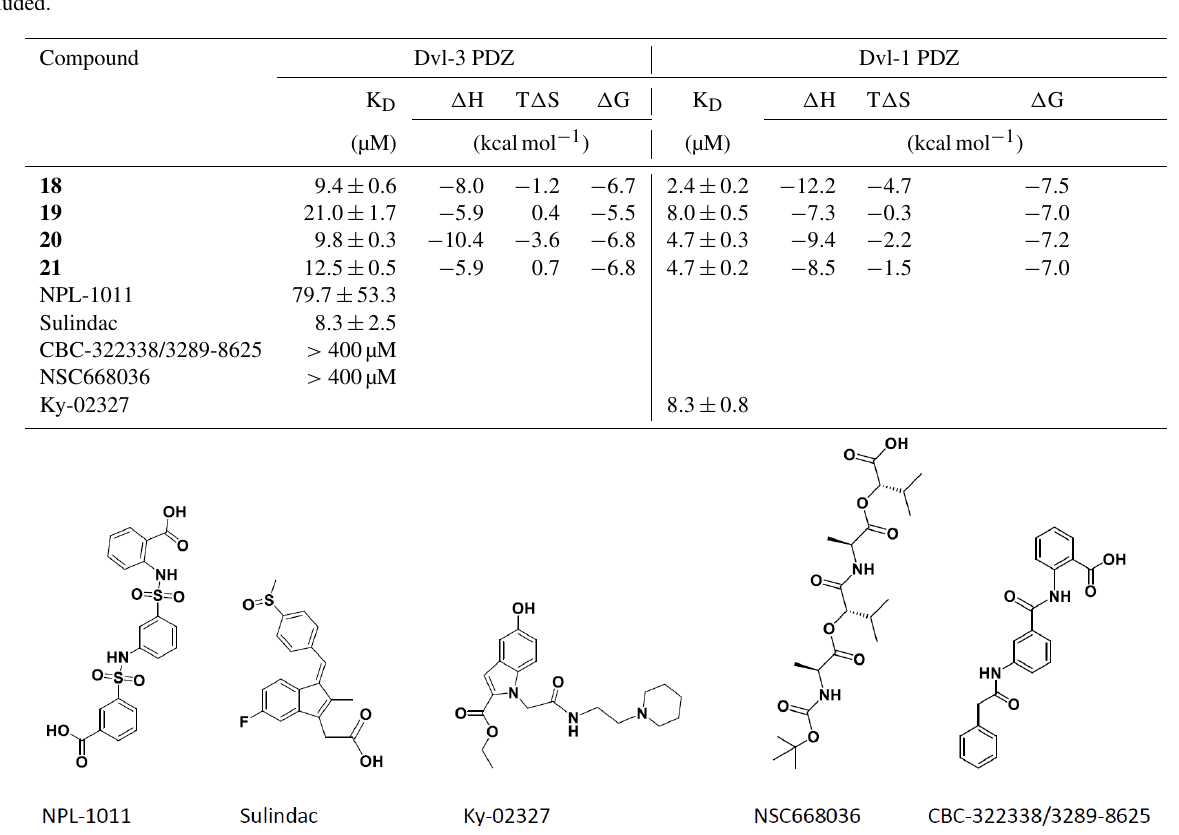
Table 2. Isothermal titration calorimetric data for the reaction between Dvl-3 PDZ; Dvl-1 PDZ; and our compounds 18 , 19 , 20 , and 21 . Compounds NPL-1011 (Hori et al., 2018), Sulindac (Lee et al., 2009), CBC-322338/3289-8625 (Grandy et al., 2009; Hori et al., 2018), and NSC668036 (Shan et al., 2005) are also given; for more thermodynamic parameters, see Fig. S7. For Ky-02327, the value from literature is included. Compound Dvl-3 PDZ Dvl-1 PDZ K D (cid:49) H T (cid:49) S (cid:49) G K D (cid:49) H T (cid:49) S (cid:49) G (µM) (kcalmol − 1 ) (µM) (kcalmol − 1 ) 18 9 . 4 ± 0 . 6